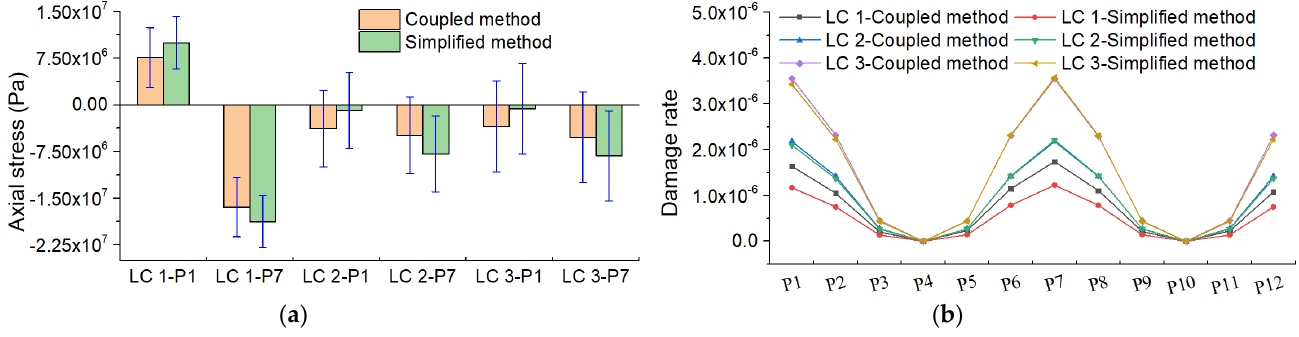
Figure 15. Fatigue plot of tower base under different load cases: ( a ) Axial stress; ( b ) Damage rate.